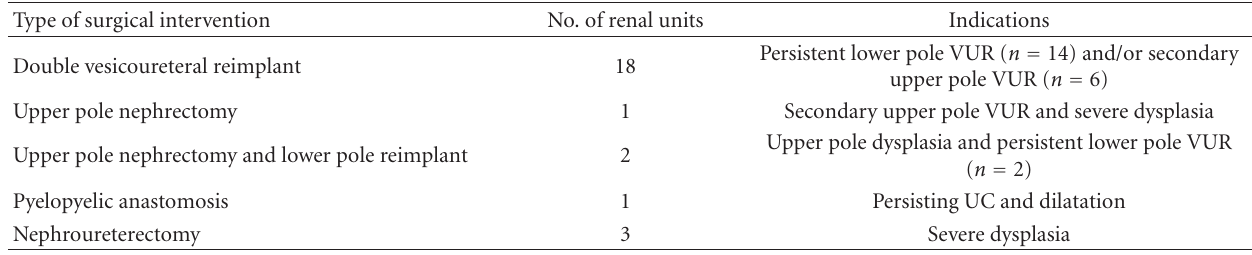
Table 3: Type and details of secondary surgery